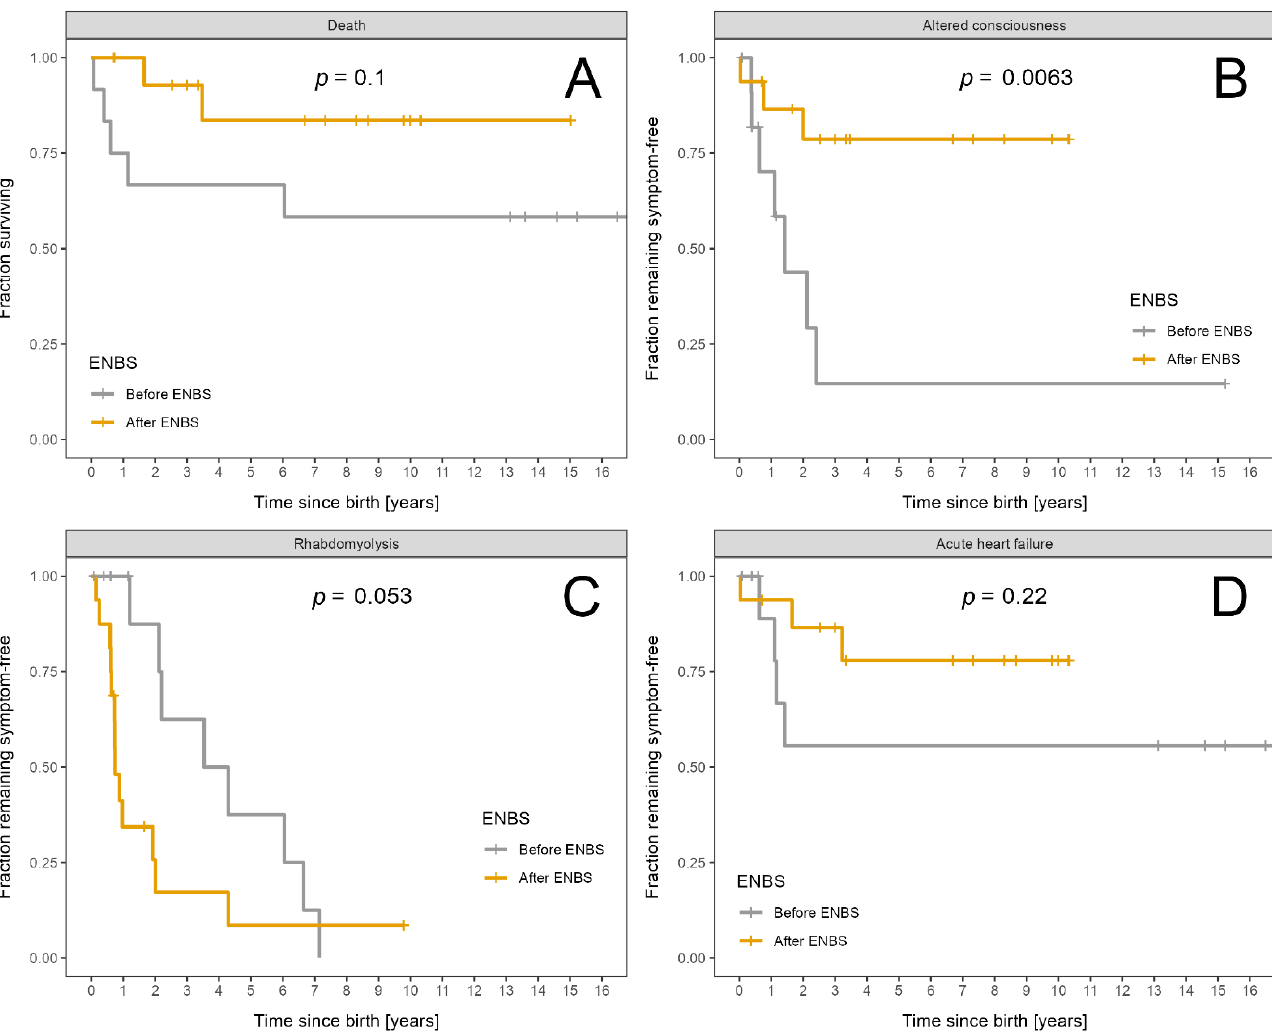
Figure 3 . Fraction of LCHADD/MTPD patients remaining alive and symptom free: Patients diagnosed before ENBS ( n = 12) are shown as grey and patients diagnosed after ENBS ( n = 16) as orange curves, respectively. ( A ) Survival probability. ( B ) Absence of any episode of altered consciousness. ( C ) Absence of rhabdomyolysis. ( D ) Absence of acute heart failure. Kaplan–Meier estimator was used; p designates significance of difference between the cohorts.